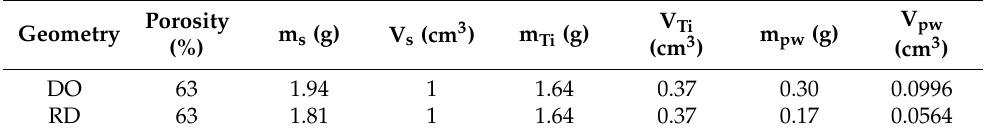
Table 5. Experimental values resulting from XCT analysis and calculated values of residual pow- der weight (m pw ) and volume (V pw ). m s —total scaffold mass; V s —total scaffold volume; m Ti —total mass of struts; V Ti —total volume of struts; m pw —total mass of residual powder; V pw —total volume of residual powder.